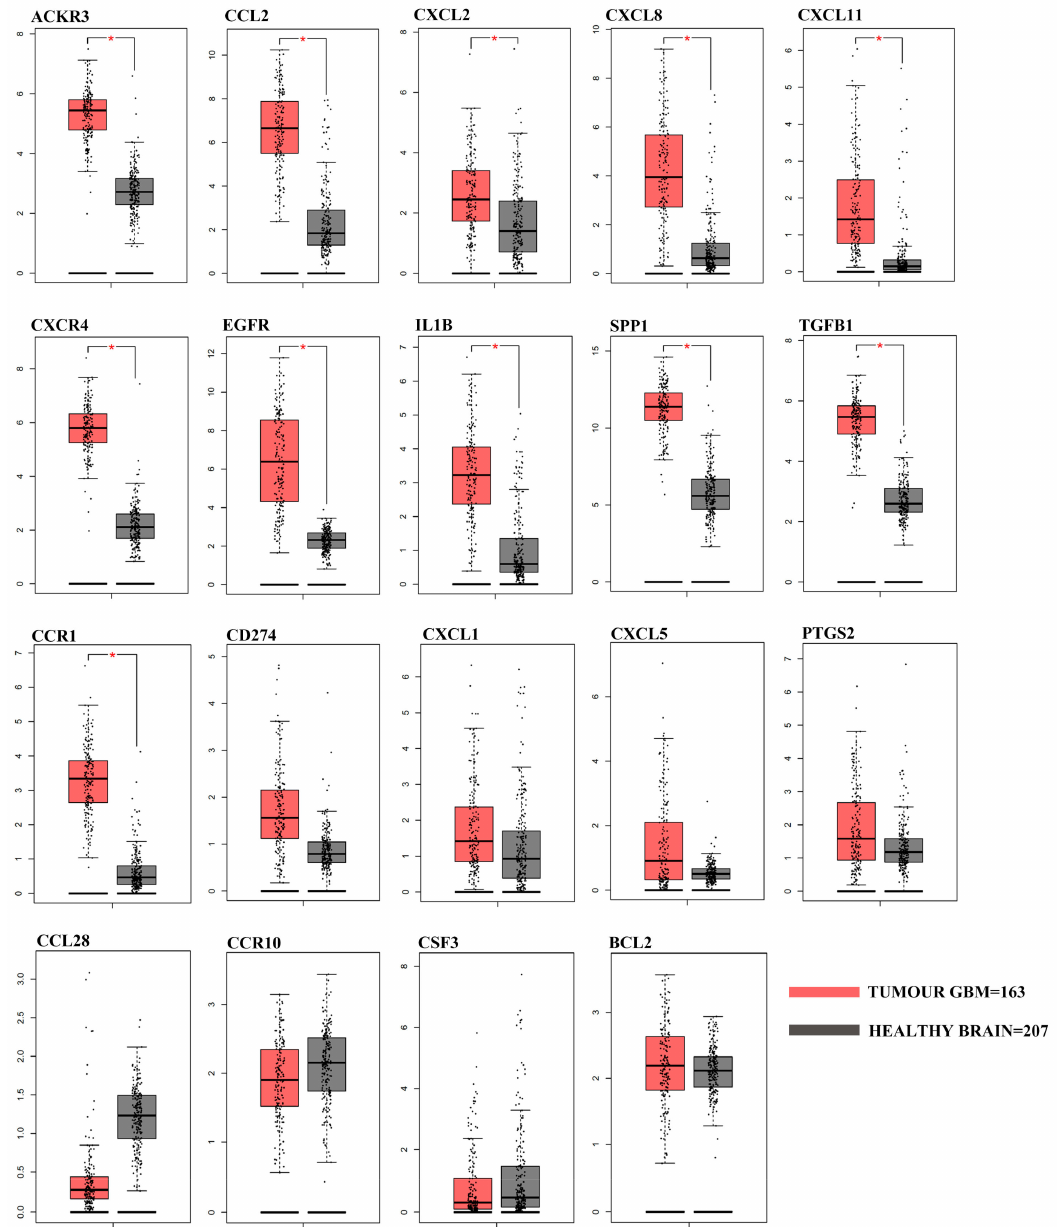
Figure 5. Di ff erential gene expression analysis in the TCGA-GBM RNA-seq dataset. Box plots represent the gene expression levels in the TCGA-GBM dataset ( n = 163) and in the TCGA-GTEx matched normal samples ( n = 207) of the 19 di ff erentially expressed genes identified with the RT2 Profiler array. Data was obtained and plotted from the GEPIA web server ( | Log2FC | Cuto ff : 1; * p value <